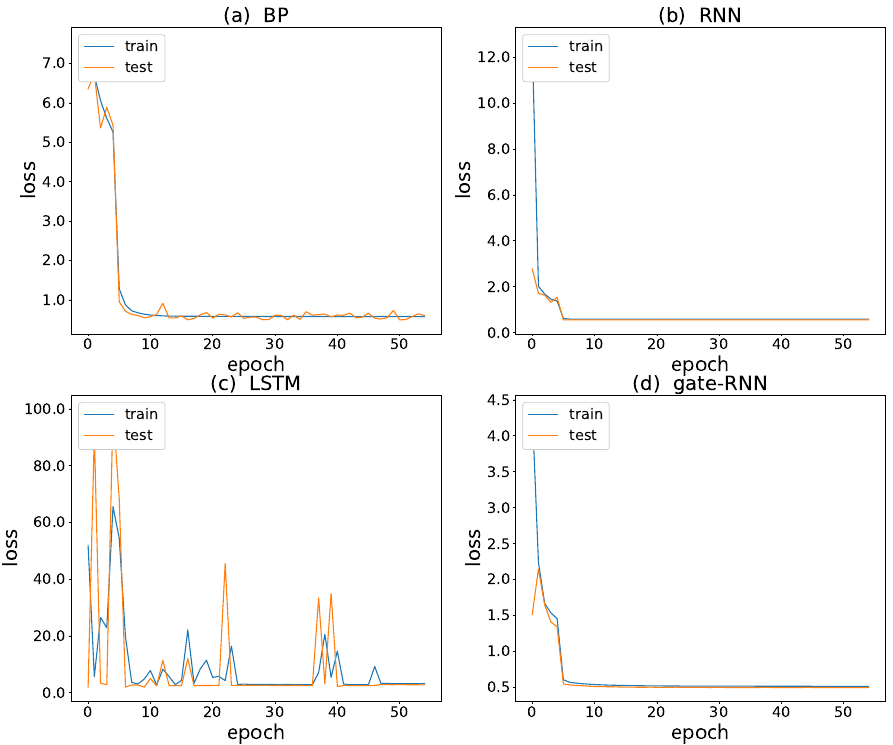
Figure 12. Neural networks’ losses on the train and test datasets for 5-min time scales: ( a ) loss of BPNN; ( b ) loss of RNN; ( c ) loss of LSTM; and ( d ) loss of gate-RNN. The blue line is the train loss curve and the orange line is the test loss